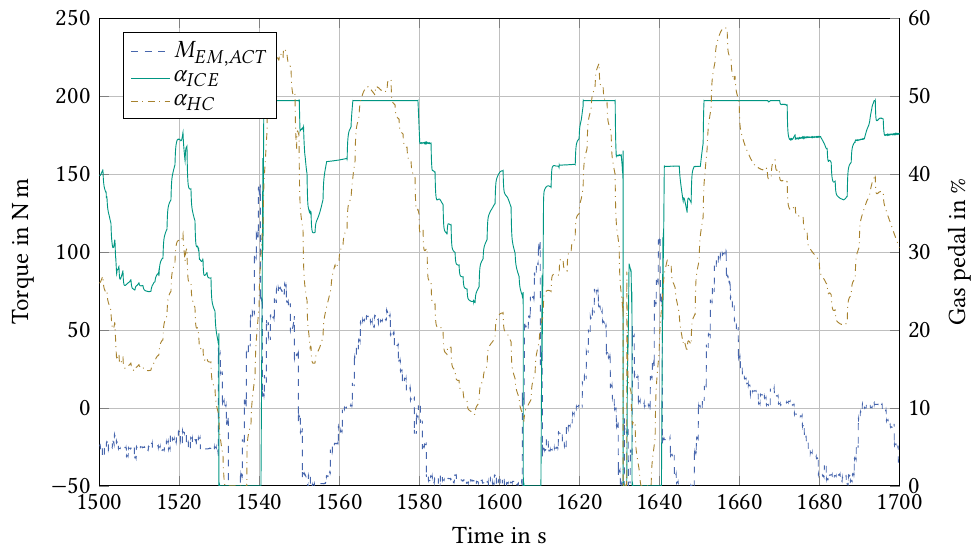
Figure 10. Accelerator pedal α HC and throttle valve position α ICE in a WLTC compared to the actual torque of the EM M EM , ACT